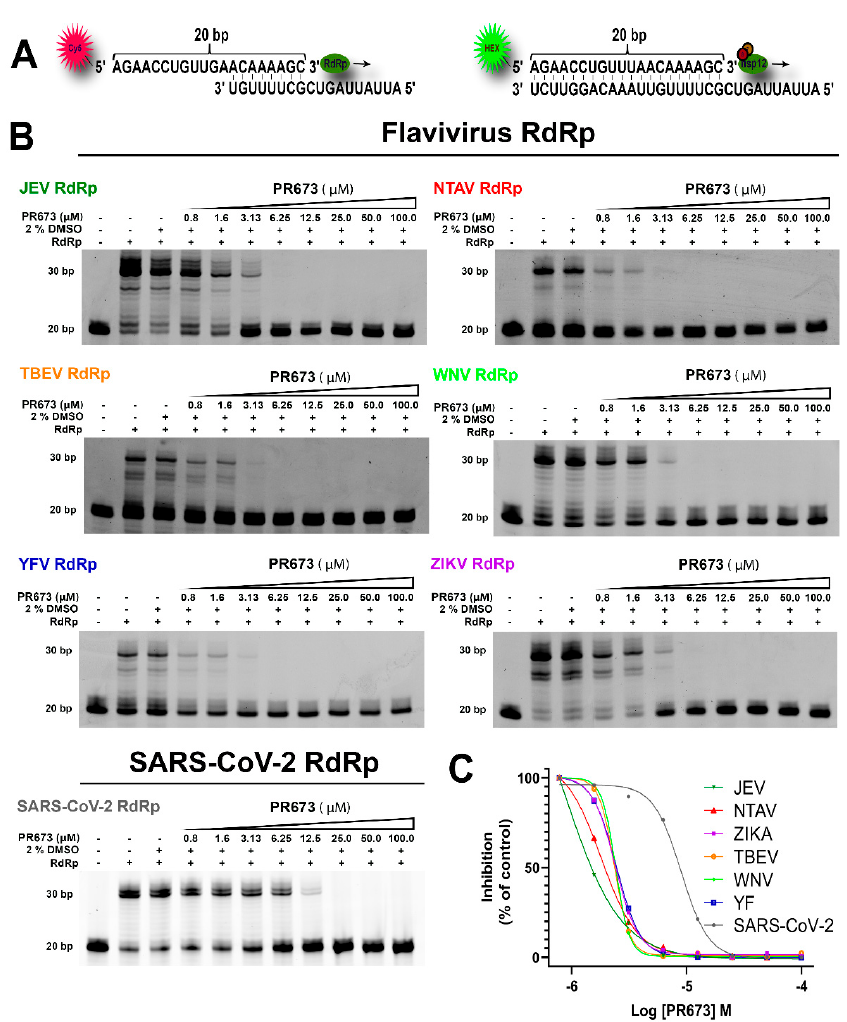
Figure 2. Analysis of PR673 inhibitory activity against various RdRps using a primer extension assay. ( A ) The RNA primer and RNA templates used in this assay. The RNA primer contains a fluorescent label at the 5 ′ end (Cy5 or Hex for flaviviral RdRp, or SARS-CoV-2 RdRp, respectively). The arrow indicates the direction of primer extension. ( B ) Serial dilutions of PR673 (in µM), as indicated on the top of the gel, and a constant concentration of the polymerase (20 nM) and template/primer (10 nM) were used in the assay. The reactions were initiated by adding 10 µM NTPs. The reactions continued at 33 °C for 1 h; then, the reactions were stopped by the addition of stop buffer, and the products were separated on denaturing polyacrylamide gels. ( C ) The percentages of inhibition (against control) in panel B were plotted against the logarithm of concentrations of PR673; the results were fitted to sigmoidal dose–response curves.